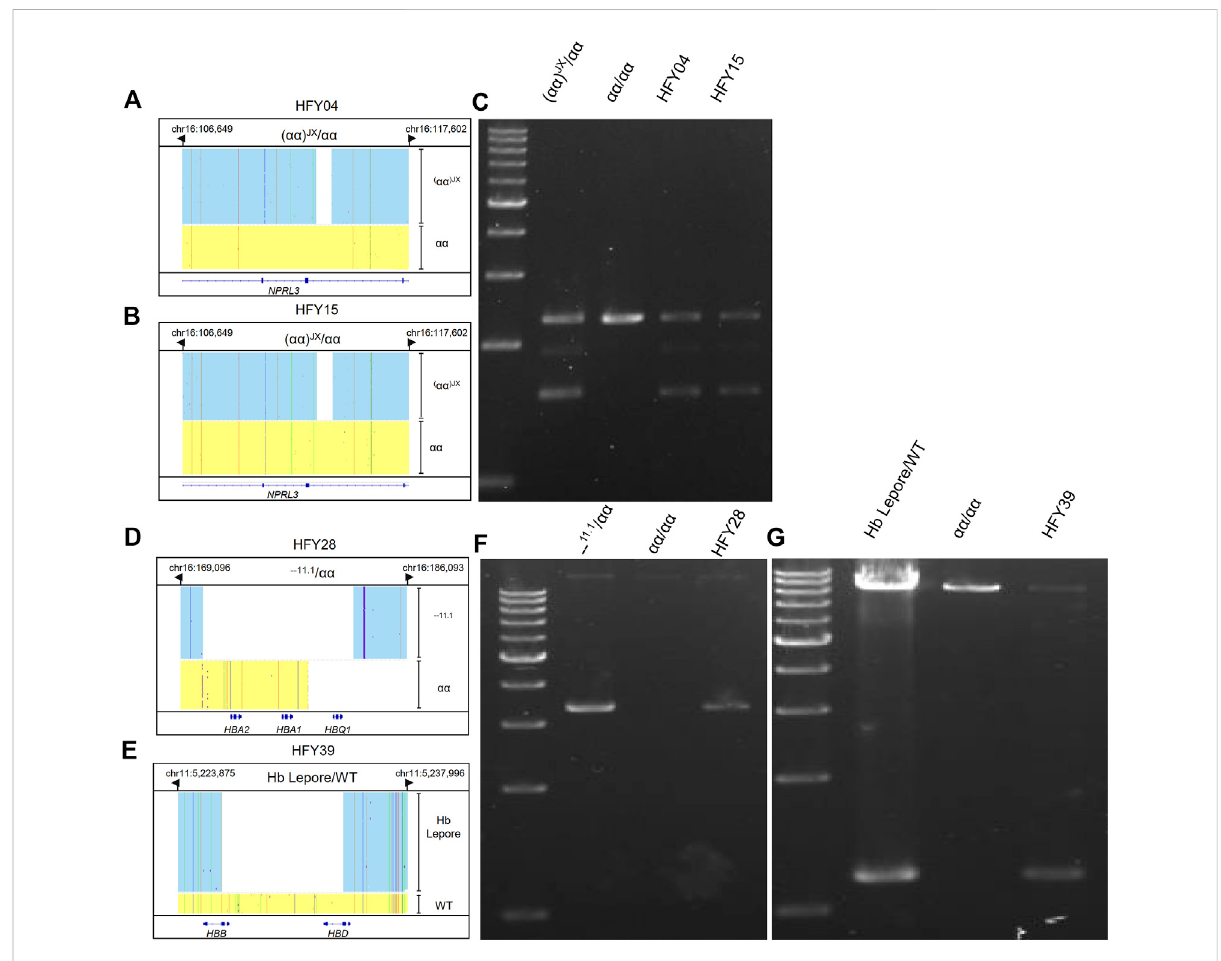
FIGURE 3 IntegrativeGenomicsViewerplotsandPCRcon fi rmationofthelargedeletionsidenti fi edbyCATSA. (A,B,D,E) IGVplotsof( αα ) JX / αα ,-- 11.1 / αα ,and Hb Lepore/WT. Blue and yellow areas indicate two chromosomes. (C,F,G) GAP-PCR and agarose gel electrophoresis identi fi ed the three large deletions of ( αα ) JX / αα , -- 11.1 / αα , and Hb